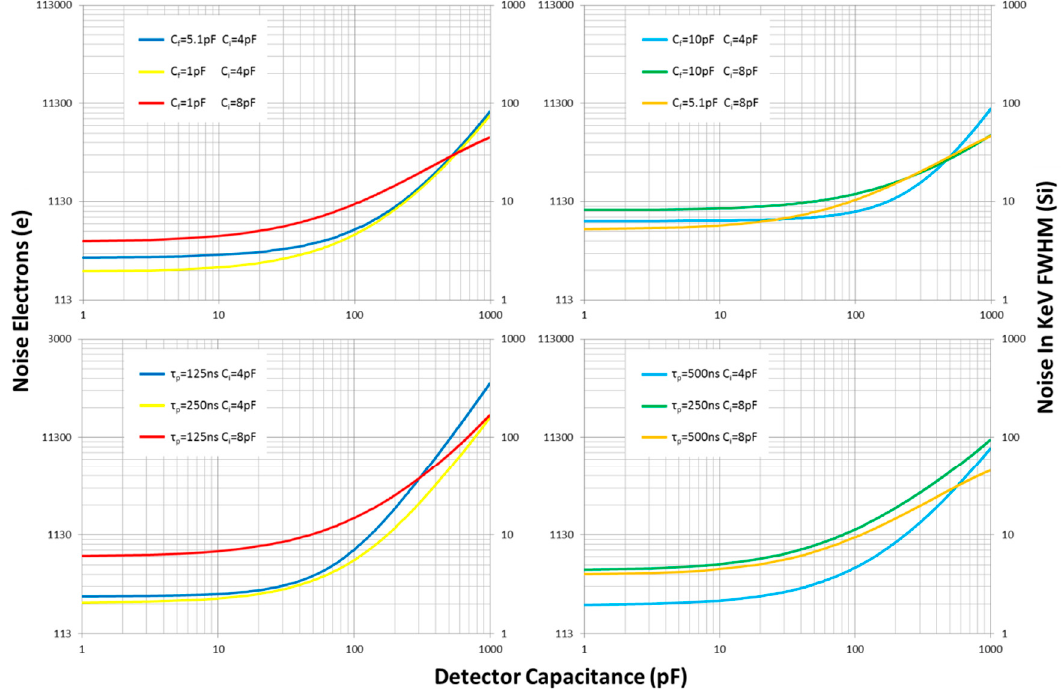
Figure 11. The readout noise as a function of the MCP detector’s capacitance C D , feedback capacitance C f , peaking time of the pulse shaper τ p and input capacitance of readout circuits C i . The total input capacitance consists of the anode capacitance and the parasitic capacitance at the input